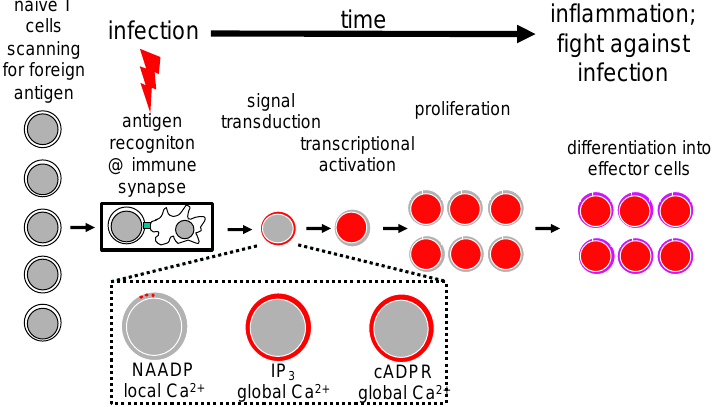
Figure 1. Ca 2+ signaling as an essential part of signal transduction during T cell activation in infection. Figure 1 displays schematically the start of activation of T cells by APC in the context of the immune synapse and the